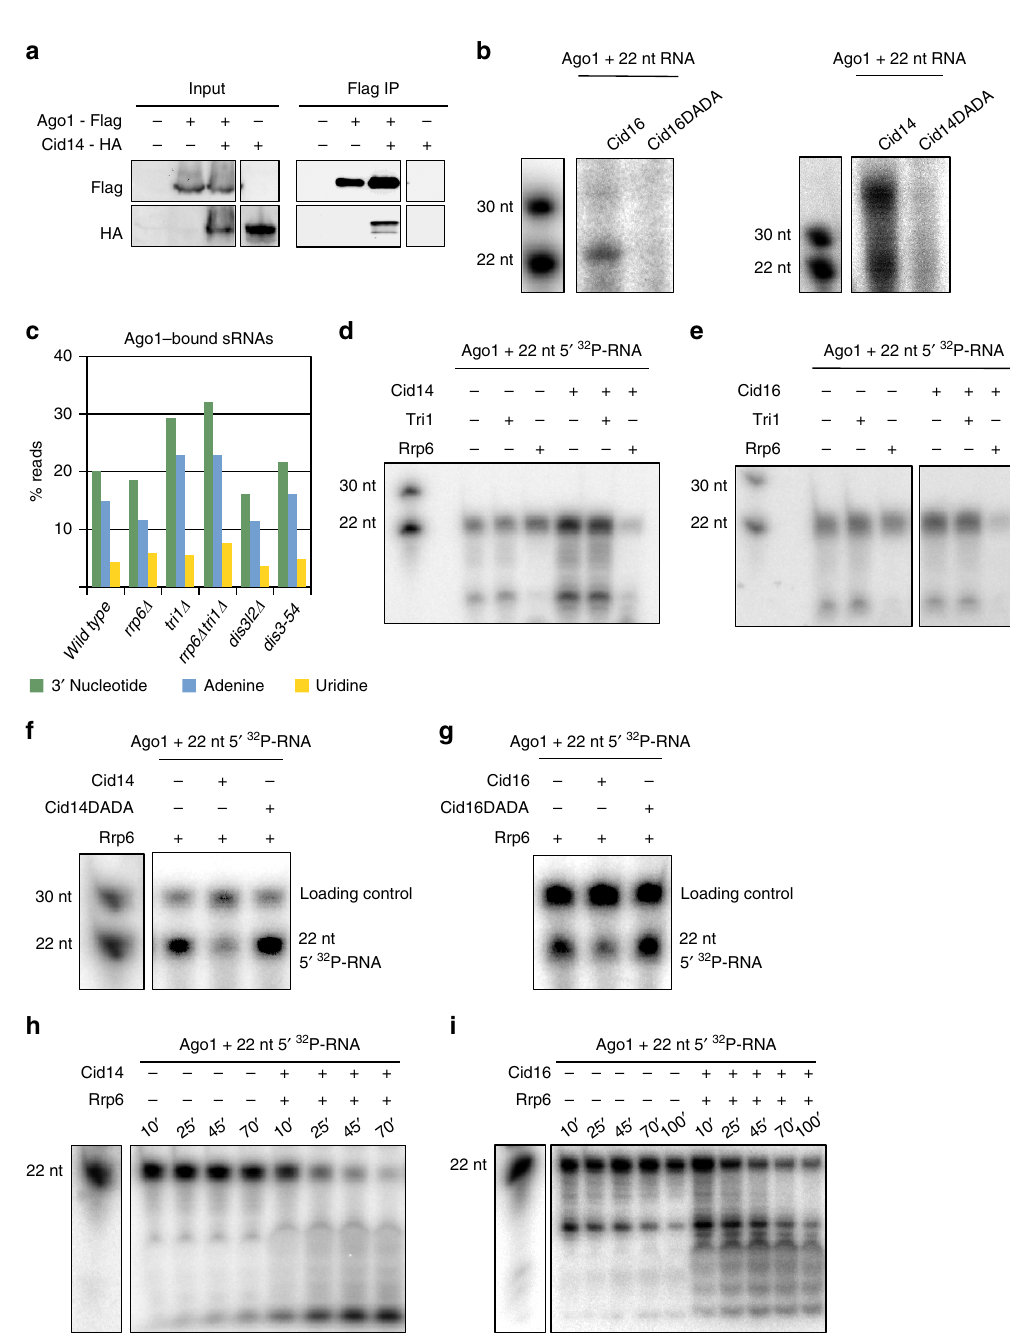
Figure 5 | Cid14/Cid16 and Rrp6 degrade Argonaute-bound sRNAs. ( a ) Western blotting analysis of co-immunoprecipitation assay showing that Argonaute interacts with Cid14 in vivo . ( b ) Autoradiograph of denaturing polyacrylamide gel showing Cid14 and Cid16 activity on Argonaute-bound sRNA. 22 nucleotide long sRNA was loaded onto empty Argonaute purified from dcr1 D tri1 D cells 9 . Argonaute was incubated with Cid14/Cid16 and 32 P a -ATP/ a -UTP and sRNA was analysed on denaturing polyacrylamide gel. ( c ) Quantification of Argonaute-bound sRNAs that have non-templated nucleotides at the 3 0 end in indicated strains. ( d , e ) Autoradiograph of denaturing polyacrylamide gel showing degradation of Argonaute-bound sRNA by Cid14, Cid16 and Rrp6. 5 0 32 P-labelled 22 nucleotide long sRNA was loaded onto empty Argonaute purified from dcr1 D tri1 D cells. Argonaute was incubated with Cid14, Cid16 and Triman or Rrp6. ( e ) Autoradiograph of denaturing polyacrylamide gel showing degradation of Argonaute-bound sRNA by Cid16 and Rrp6. 5 0 32 P-labelled 22 nucleotide long sRNA was loaded onto empty Argonaute purified from dcr1 D tri1 D cells. Argonaute was incubated with Cid16 and Triman or Rrp6. ( f ) Autoradiograph of denaturing polyacrylamide gel showing degradation of Argonaute-bound sRNA by Cid14 and Rrp6. 5 0 32 P-labelled 22 nucleotide long sRNA was loaded onto empty Argonaute purified from dcr1 D tri1 D cells. Argonaute was incubated with Rrp6, Cid14 and Cid14DADA. 30 nucleotide long DNA was used as a loading control. ( g ) Autoradiograph of denaturing polyacrylamide gel showing degradation of Argonaute-bound sRNA by Cid16 and Rrp6. 5 0 32 P-labelled 22 nucleotide long sRNA was loaded onto empty Argonaute purified from dcr1 D tri1 D cells. Argonaute was incubated with Rrp6, Cid16 and Cid16DADA. 30 nucleotide long DNA was used as a loading control. ( h , i ) Autoradiograph of denaturing polyacrylamide gel showing time course of Argonaute-bound sRNA degradation by Cid14/Cid16 and Rrp6. 32 P-labelled 22 nucleotide long sRNA was loaded onto empty Argonaute purified from dcr1 D tri1 D cells. Argonaute was incubated with Rrp6, Cid14 ( h ) or Cid16 ( i ). Time when reaction was stopped is indicated above the